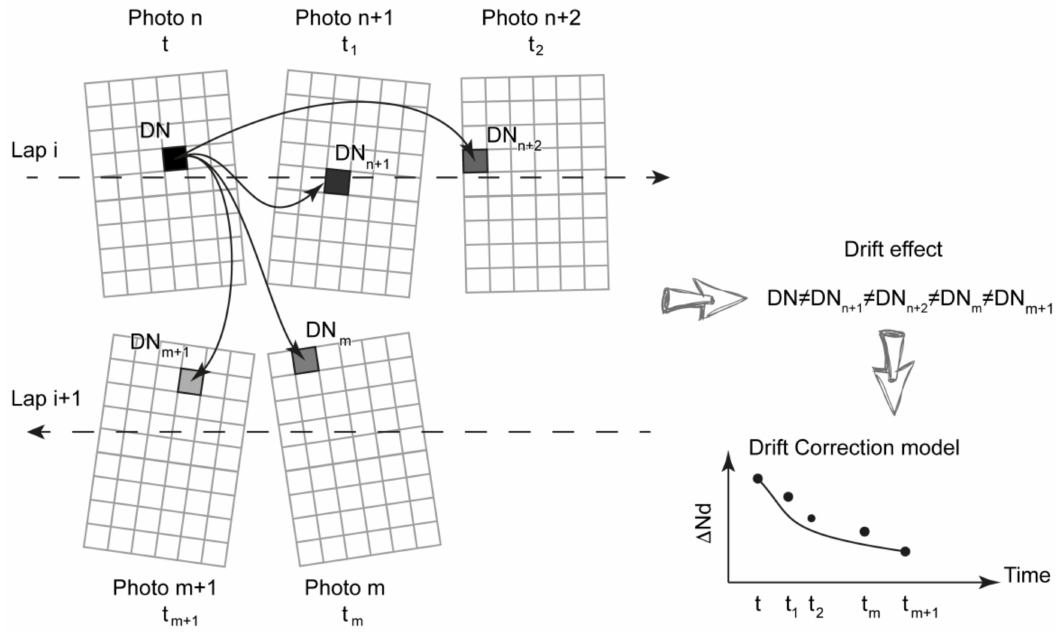
Figure 3. Graphical description of thermal drift correction model (DN: digital number, t: